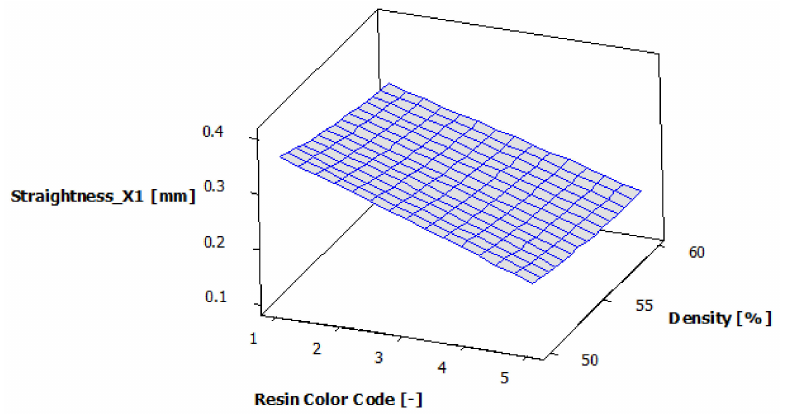
Figure 16. Estimated response surface for Straightness_X1.